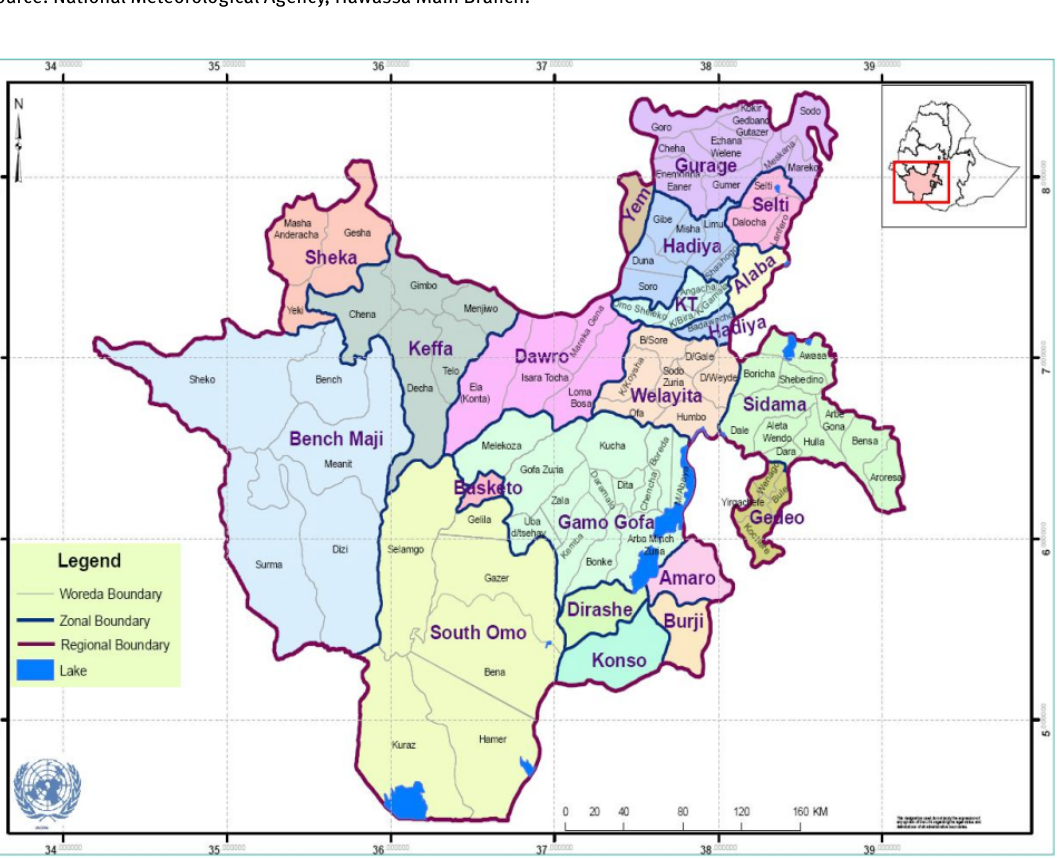
Figure 1: Map of SNNPR showing the areas where the study was